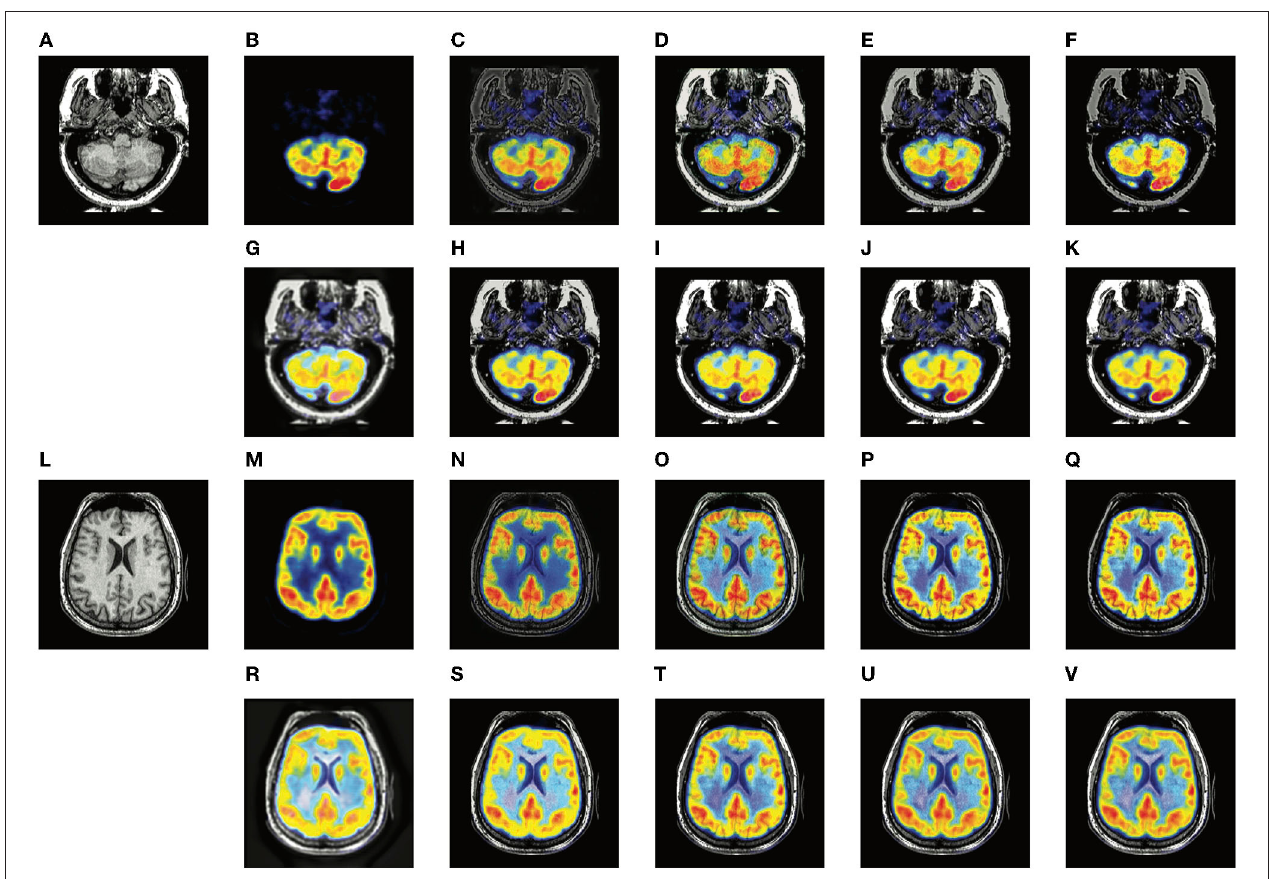
FIGURE 5 | Experiments results of proposed method with six deep learning-based methods on two typical MRI and PET image pairs. (A,L) MRI images; (B,M) PET images; (C,N) fused results of DDcGAN; (D,O) fused results of EMFusion; (E,P) fused results of IFSR; (F,Q) fused results of U2Fusion; (G,R) fused results of DRF; (H,S) fused results of SEDR; (I,T) fused results of proposed-add; (J,U) fused results of proposed-max; (K,V) fused results of proposed-l1.